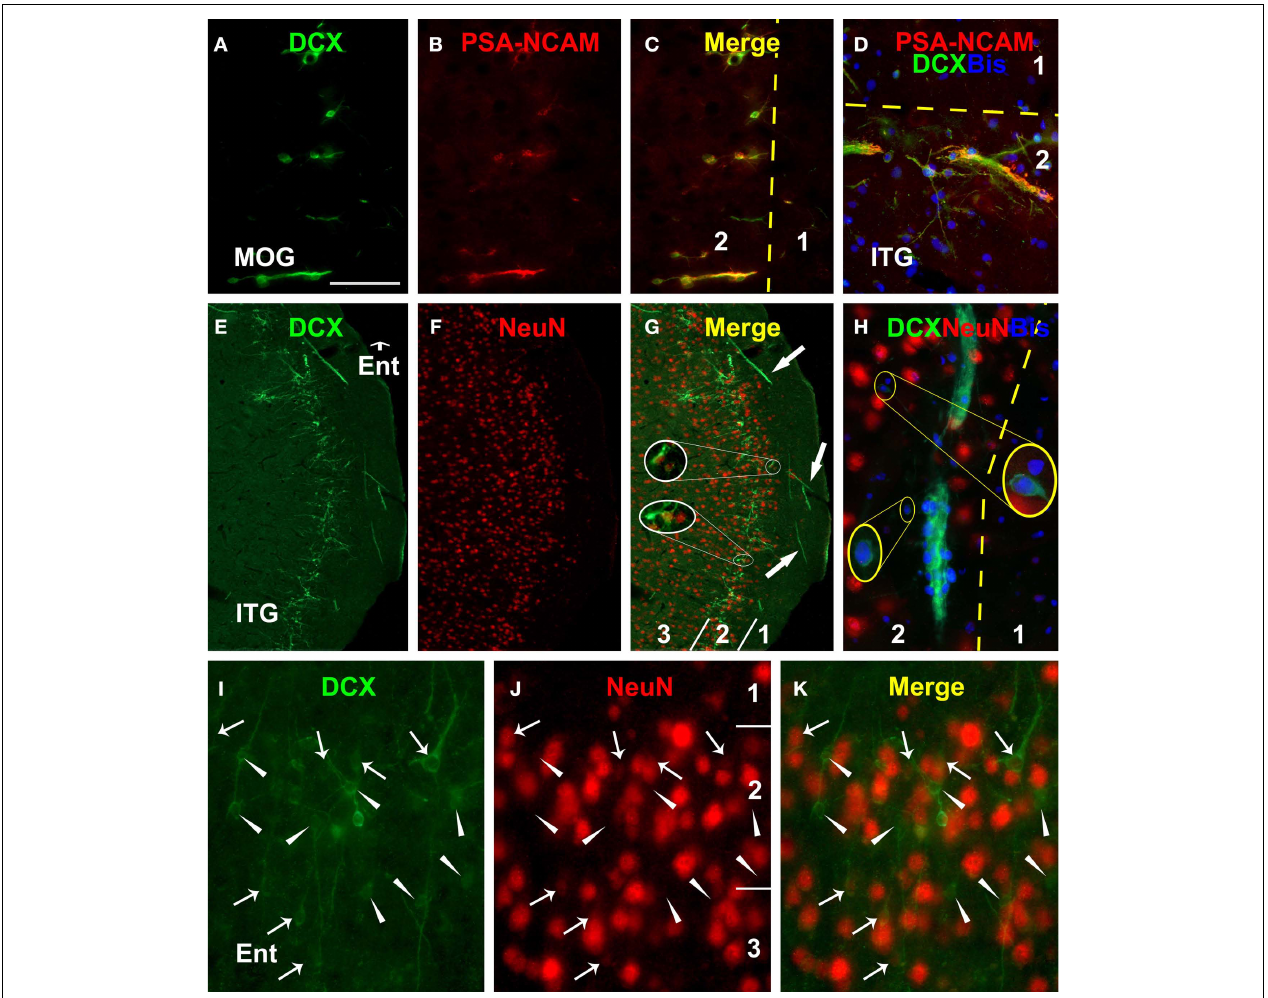
FIGURE 6 | Immunofl uorescent images from the 22-year-old monkey illustrating colocalization of polysialylated neural cell adhesion molecule (PSA-NCAM) and neuron-specifi c nuclear protein (NeuN) in DCX + cells (including bisbenzimide nuclear stain in D and H) in the prefrontal (MOG, A–C) and temporal lobe cortex (D–K). PSA-NCAM and DCX are colocalized in individual cells as well as cells arranged in chains perpendicular (A–C) or